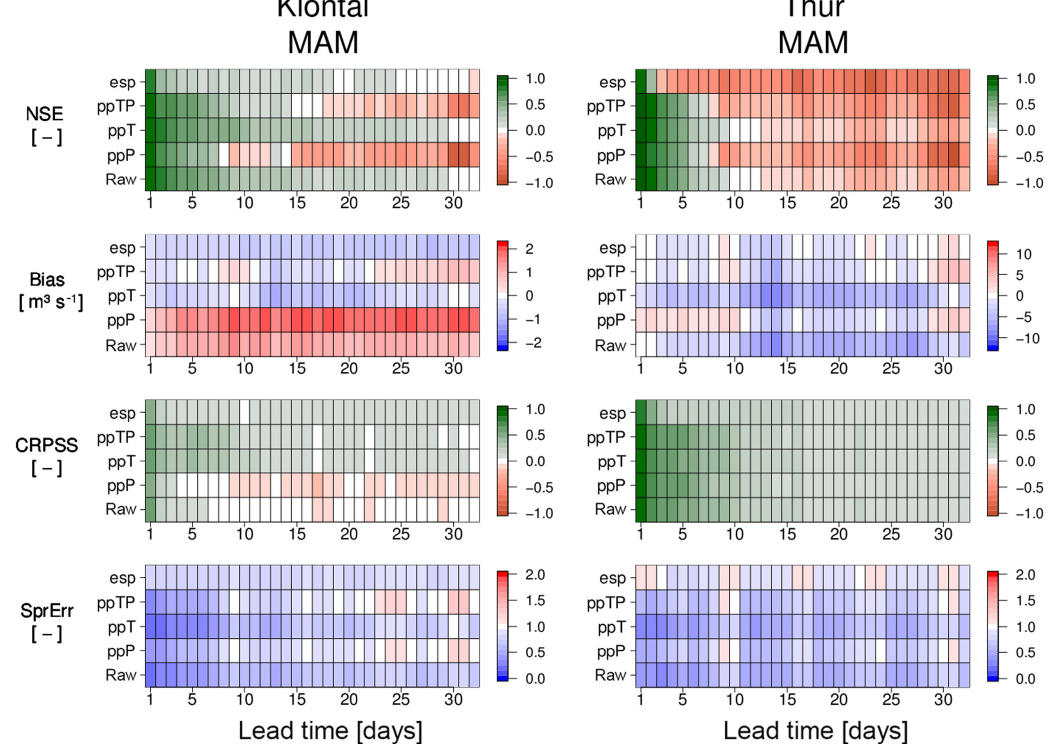
Figure 6. Same as Fig. 4 but for the Klöntal and the Thur catchment in